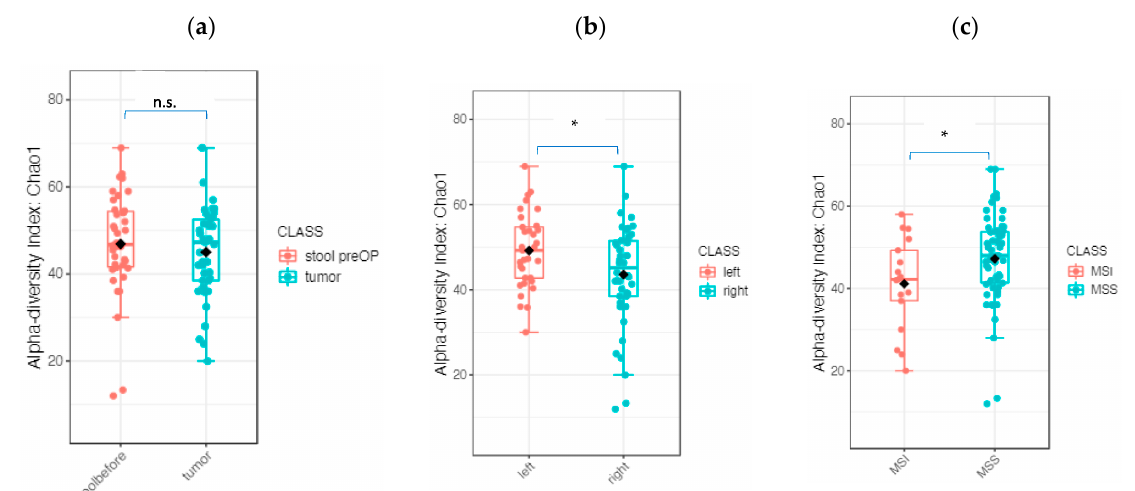
Figure 5. Microbiome composition according to tumor sidedness and MSS status: ( a ) diversity analysis using the Chao1 alpha diversity index between tumor and preoperative stool; ( b ) overall microbiome of the tumor and preoperative stool according to sidedness RSCC and LSCC; and ( c ) overall microbiome of the tumor and preoperative stool according to MSS status (* p < 0.05, n.s, not significant).